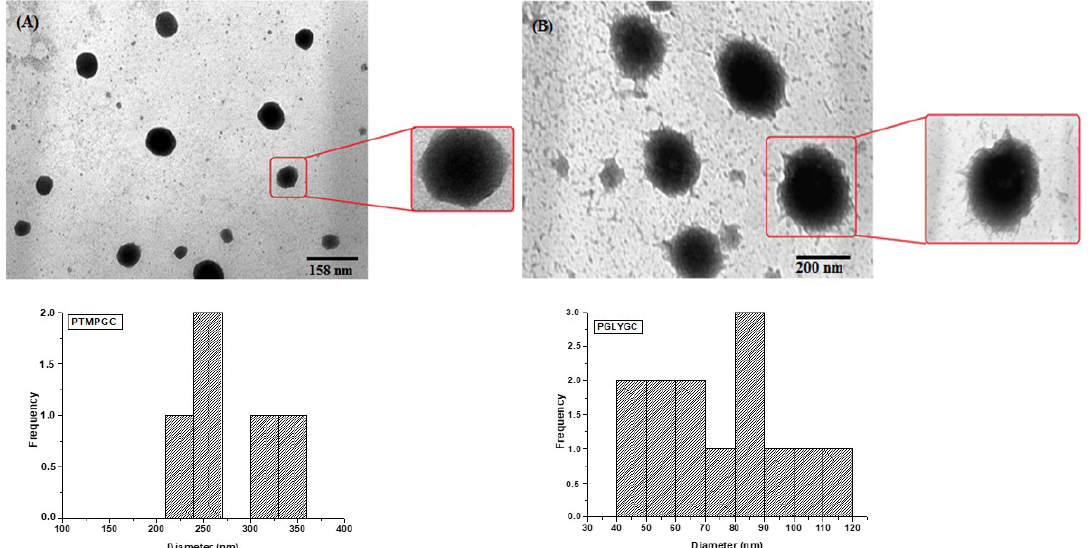
Figure 7. TEM Imagens of PGLYGC (A) and PTMCGC (B) with histograms.